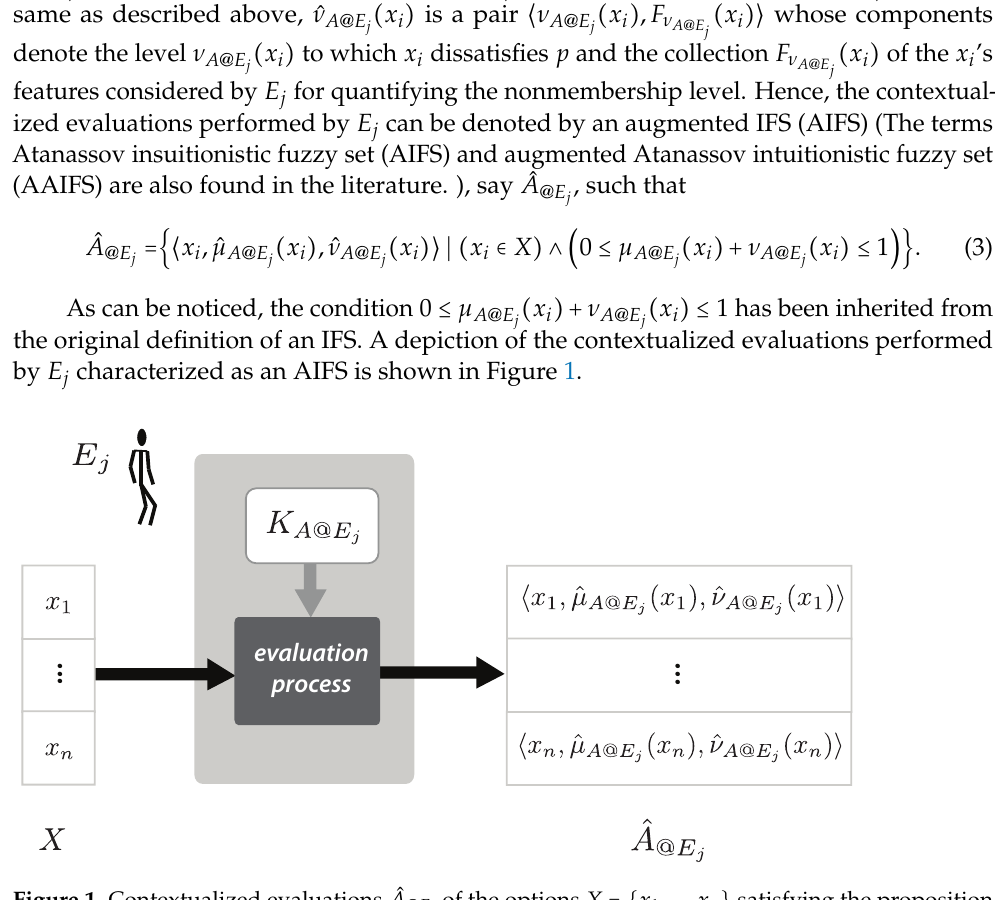
of the options X = { x 1 , ⋯ , x n } satisfying the proposition j j